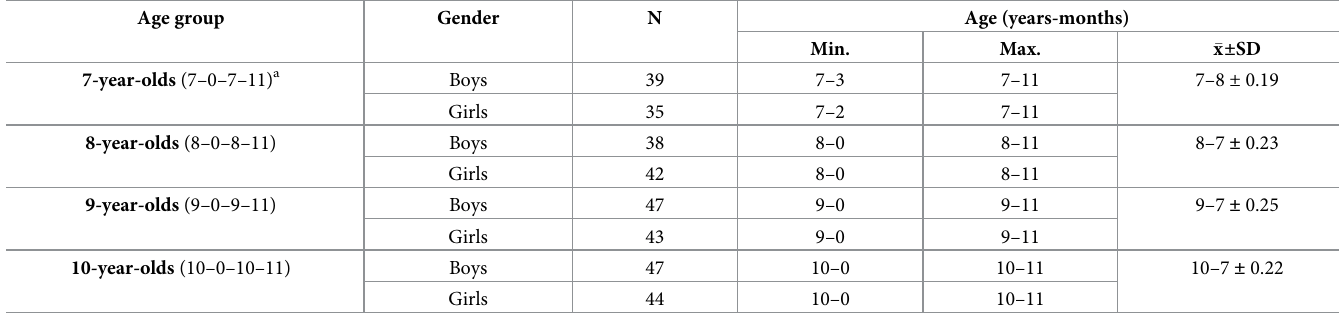
Table 1. Demographic data of the participants (n = 335). Age group